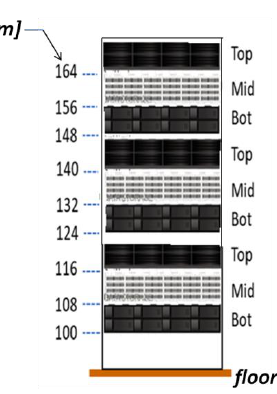
Figure 1. Example of the stack- up of the trays in a servers’ rack.